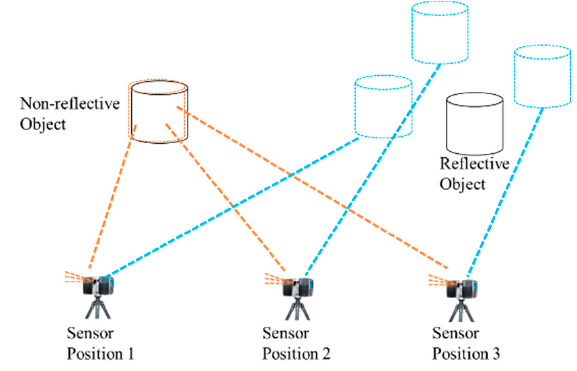
Figure 9. Schematic of the position of points in different sensors.